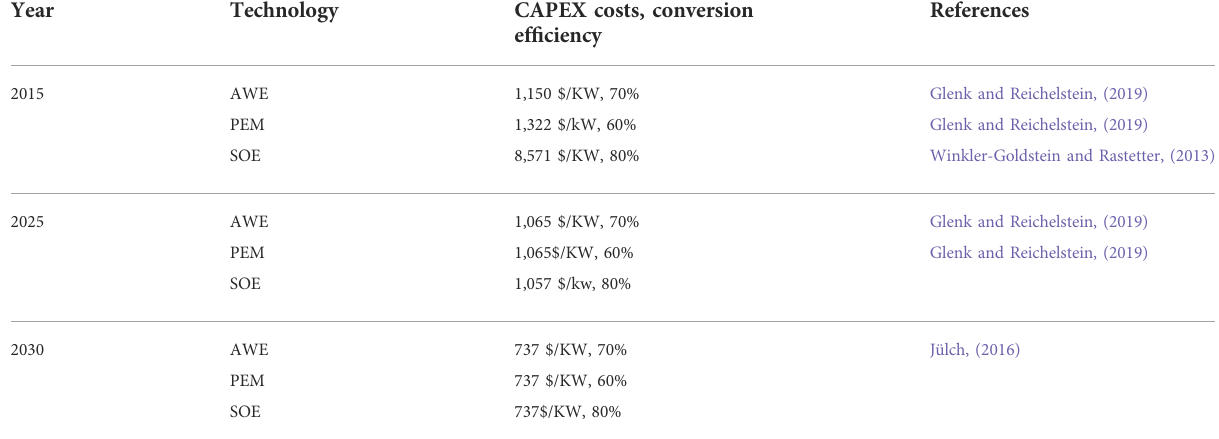
TABLE 4 Different green hydrogen technologies with cost and conversion ef fi ciency.